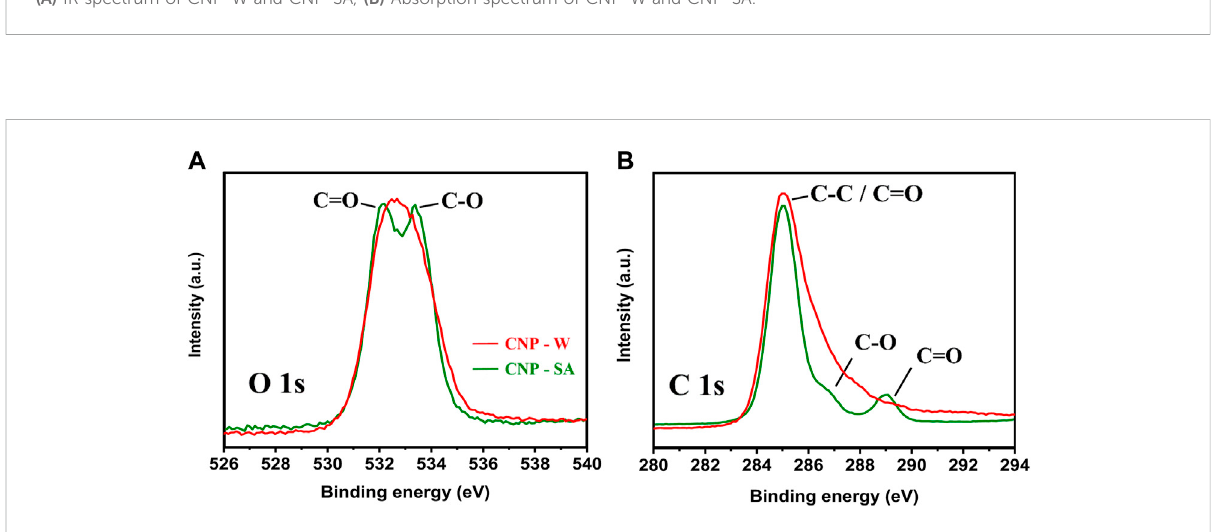
FIGURE 3 High-resolution XPS spectrum of CNP (A) O1s, (B)